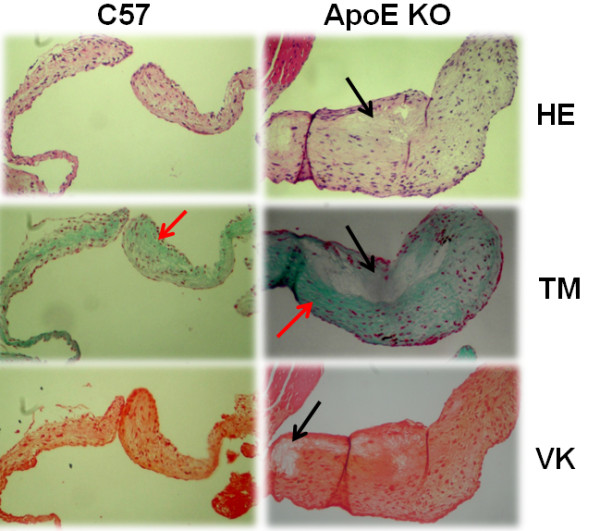
Typical photomicrographs of aortic valves on a longitudinal axis from a male aged hypercholesterolemic ApoE KO and a normocholesterolemic C57 mouse. Samples were stained with hematoxylin-eosin (HE), Masson's trichrome (MT), and von Kossa (VK). Black arrows indicate diffuse acellularity and myxoid thickening of the spongy layer (HE, MT and VK) in the ApoE KO mouse. Red arrows indicated valvular fibrosis with dense collagen (MT) mainly in the ApoE KO mouse. Magnification: 250×.